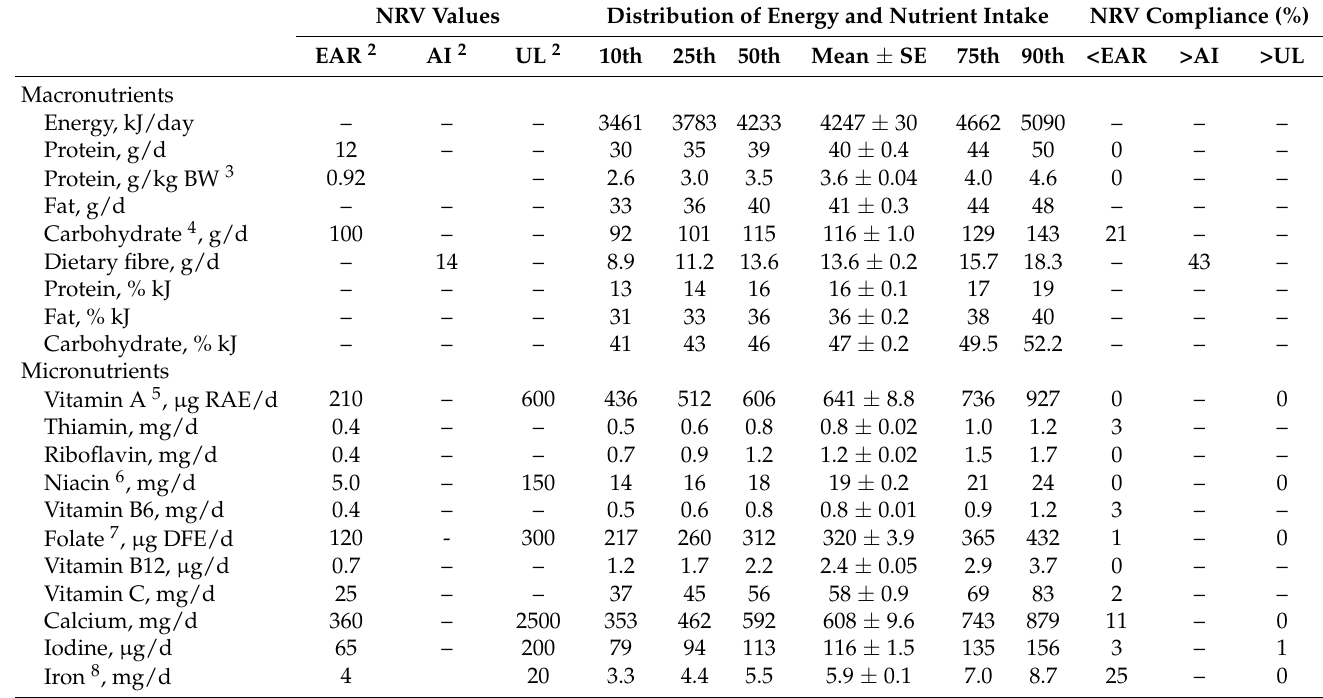
Table 4. Usual energy and nutrient intake distribution from foods and beverages for toddlers